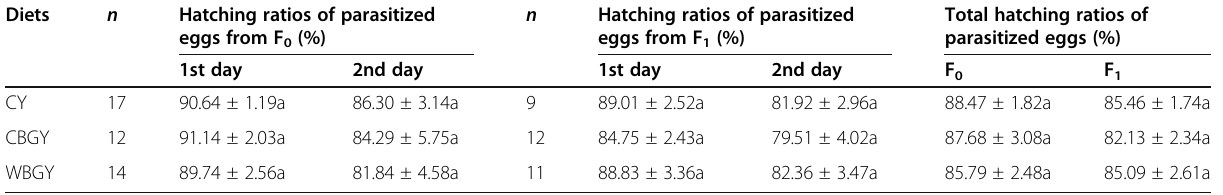
Table 7 Hatching ratios of Trichogramma evanescens parasitizing eggs of Ephestia kuehniella fed on three different diets n Hatching ratios of parasitized Diets n Hatching ratios of parasitized eggs from F 1 (%) eggs from F 0 (%)